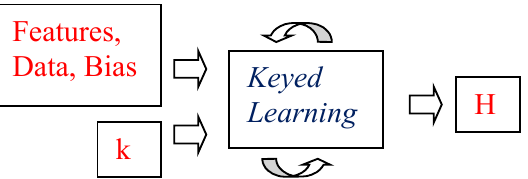
Figure 1. Keyed Learning, producing a learned hypothesis H, e.g., a classifier or a cluster.